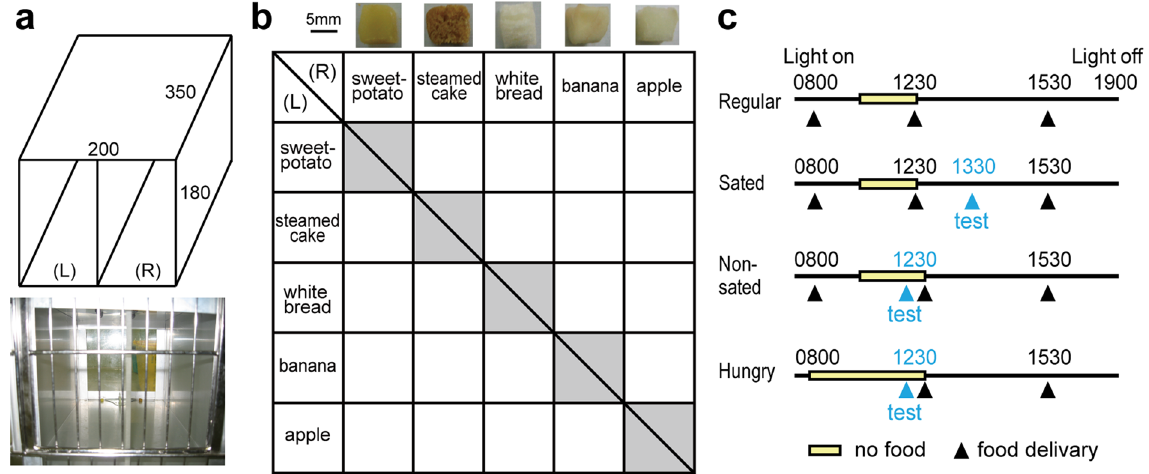
Figure 1. Experimental setting. ( a ) A schematic drawing (top) and picture (bottom) of the experimental chamber. During the pairwise food choice test, a two-armed chamber was attached to the home cage of animals. Values in the figure indicate mm. Two small food items were located at the far end of the two compartments (left/right). ( b ) Match-up matrix of the five food items with left-right alternation. All pairs (except same food pairs) were used for the pairwise choice test. Pictures of the food items are represented above the matrix with 5 mm scale bar. ( c ) Daily meal schedules in the regular condition and the three controlled food access conditions (sated, non-sated, and hungry) during the pairwise food choice